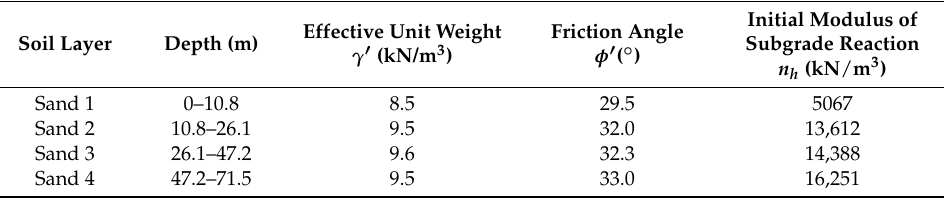
Table 3. Soil data for the Chang-Bin wind farm.